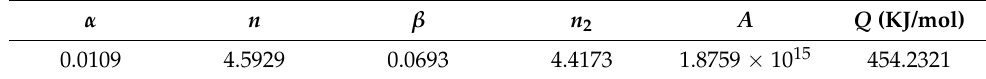
Table 2. The parameter values of equations.